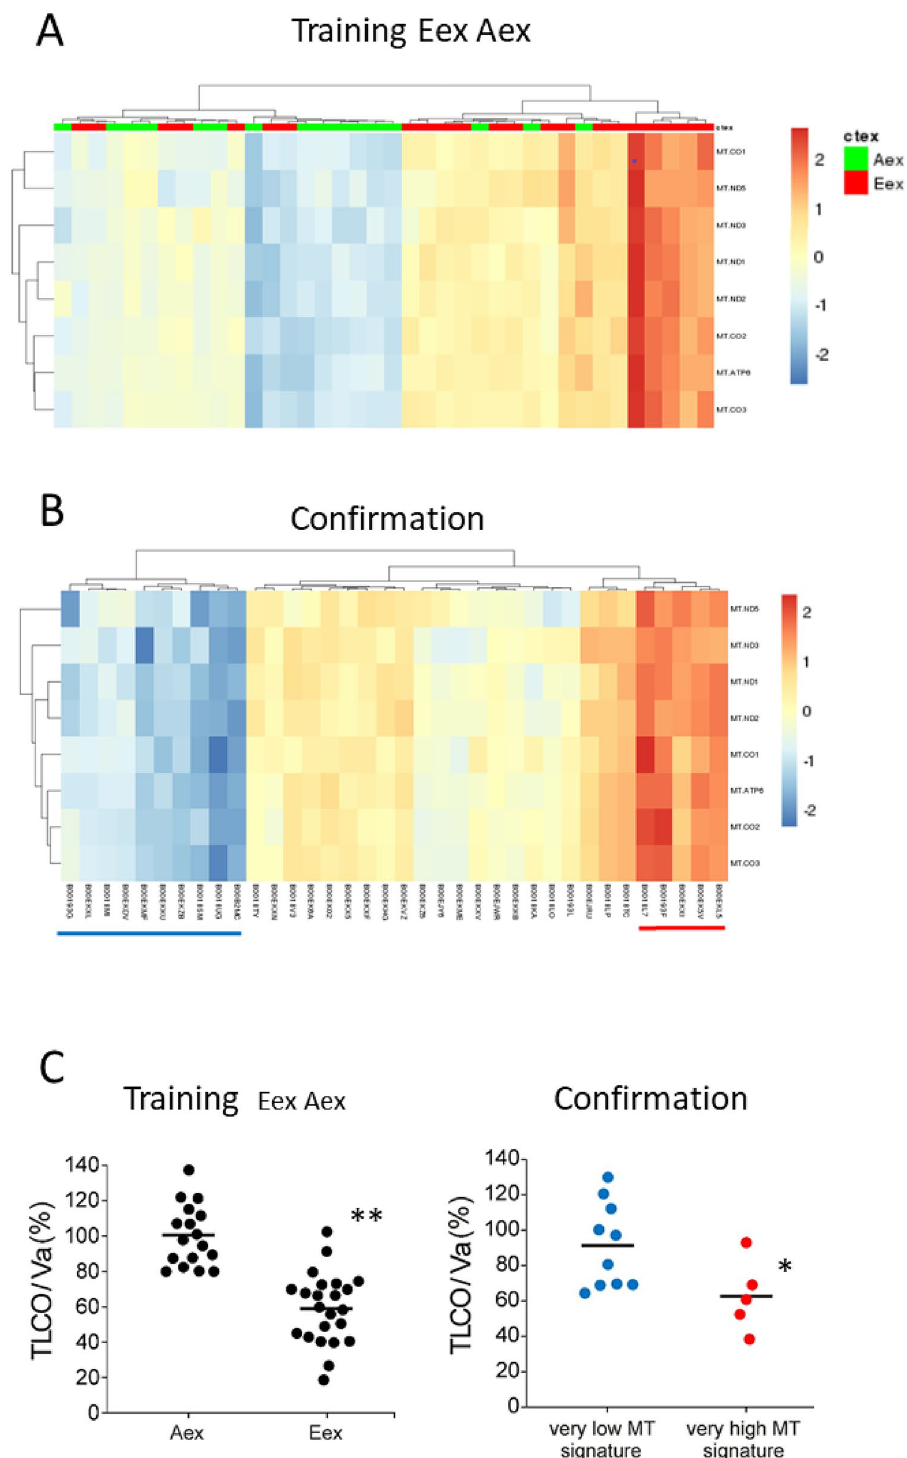
Figure 3. Mitochondrial signature for COPD sub-phenotypes The eight interacting mitochondrial genes were tested in un-supervised hierarchical clustering on Eex and Aex samples only ( A ) and on the confirmation samples ( B ). red = Eex; green = Aex. Fisher’s exact for 3A is 0.0036. ( C ) (left panel) gives TLCO/Va values for Eex and Aex samples (** p < 0.00001, Mann Whitney U test). ( C ) (right panel) gives the TLCO/Va values for the samples with very low MT gene expression marked in blue in Fig. 3B and for the samples with very high MT gene expression marked red in Fig. 3B (* p < 0.05, Mann–Whitney U test). –- = mean. The figure was produced using the R package pheatmap, pheatmap: Pretty heatmaps [Software] R Kolde, URL https:// CRAN.R- proje ct. org/ packa ge= pheat